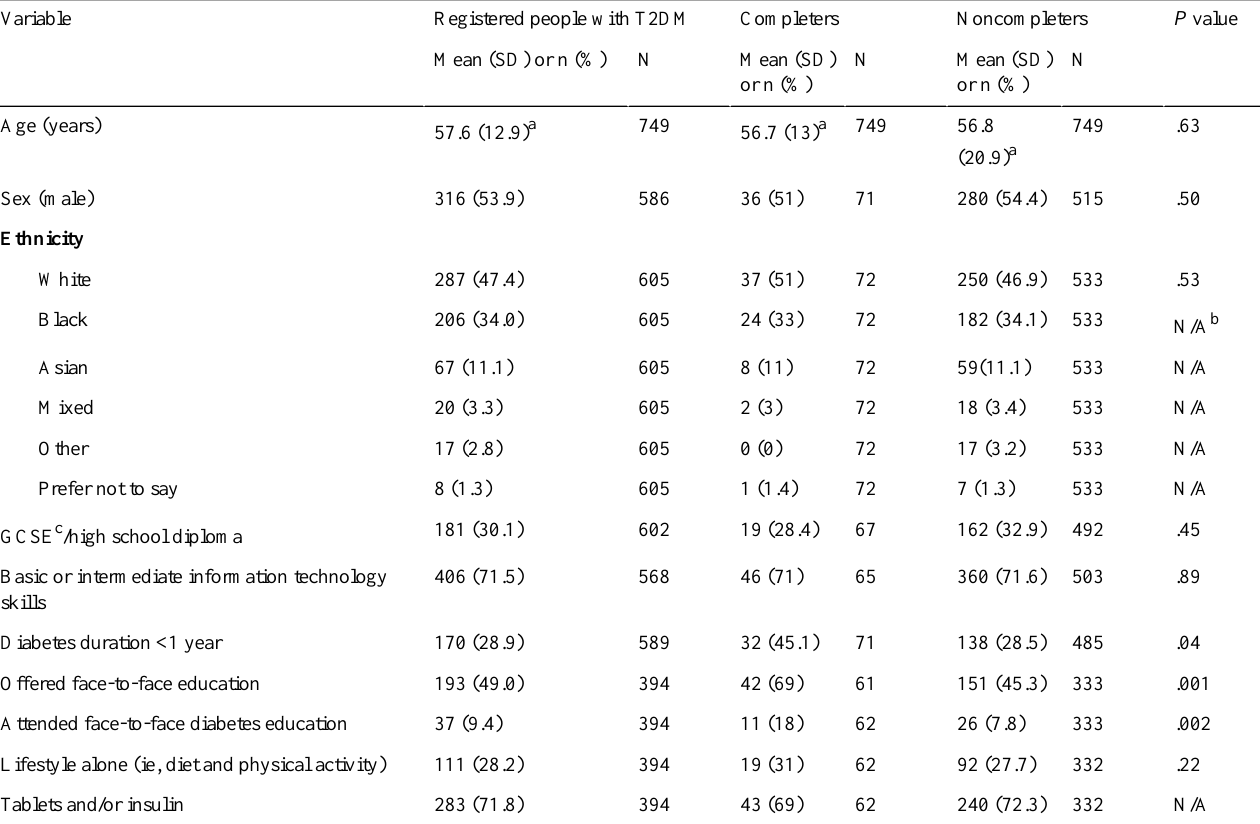
Table 3. Characteristics of registered people with type 2 diabetes mellitus (T2DM), completers, and noncompleters.